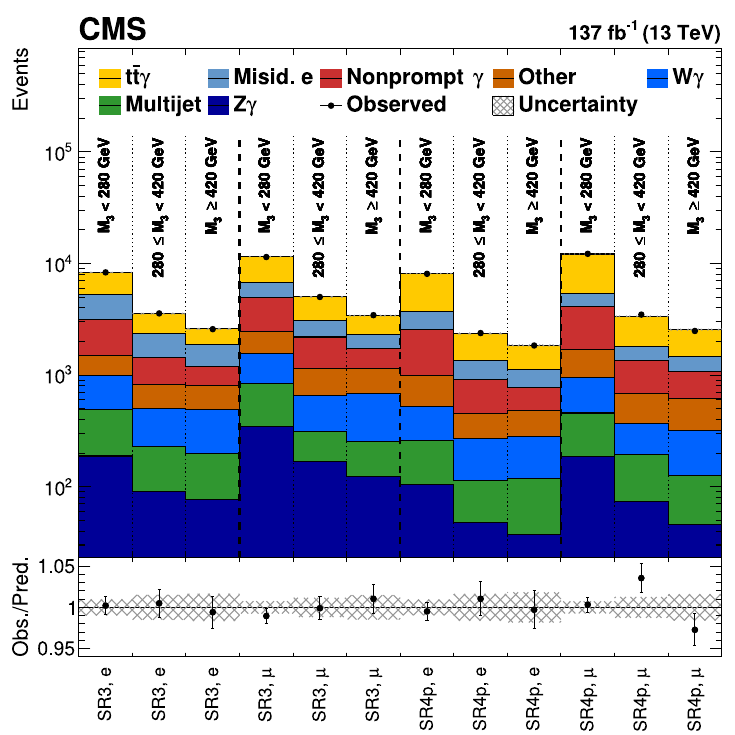
Figure 6 . Fitted and observed yields in the SR3 and SR4p signal regions using the post-fit values of the nuisance parameters. The lower panel shows the ratio of the observed to the predicted event yields. The post-fit systematic uncertainties are shown as a hatched